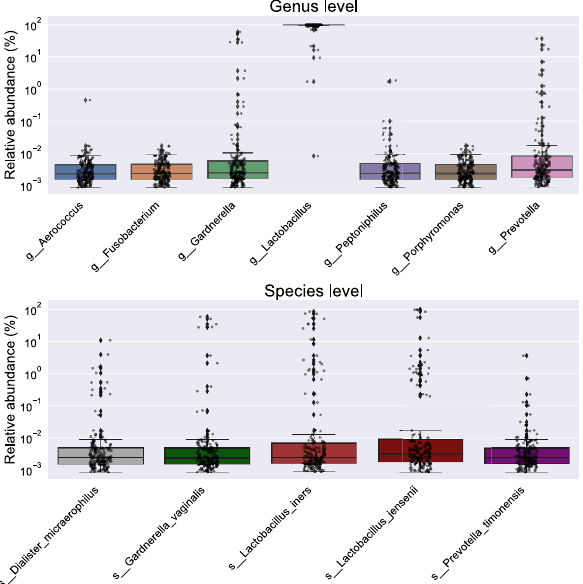
Figure 5. Relative abundance of bacteria associated with vaginal health. Only bacterial targets in uBiome’s SmartJane assay that are also present in the vaginal discharge samples are